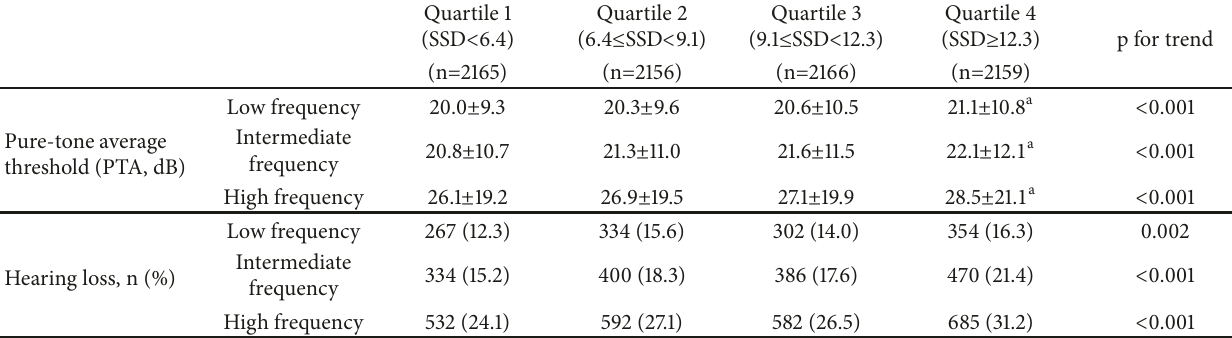
Table 2: Pure-tone average thresholds (PTAs) and hearing loss distribution in different BPV